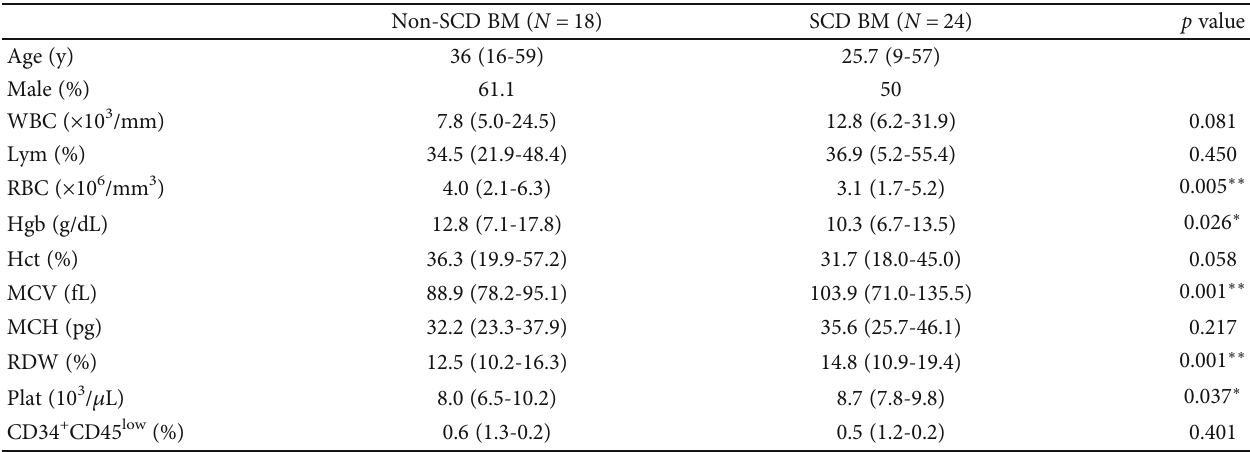
Table 2: Demographic and hematology pro fi les for the bone marrow aspirate, from the SCD and non-SCD groups.